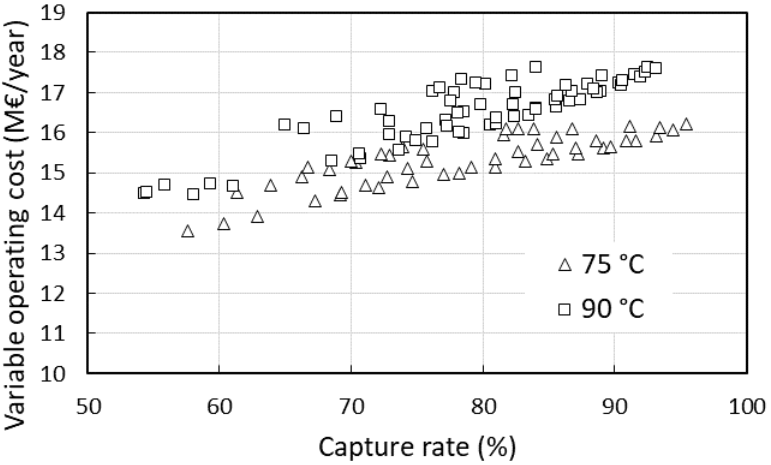
Figure 7. Effect of capture rate on the variable operating costs of the plant at different steam grades.